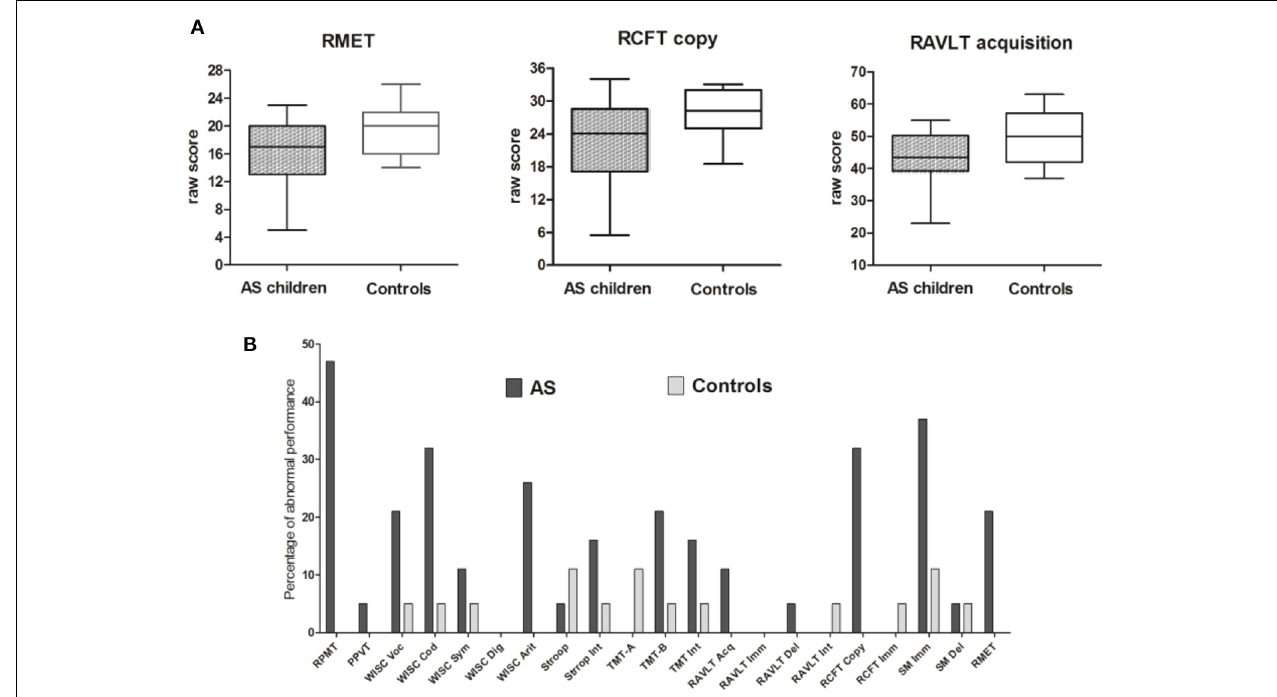
FIGURE 1 | Summary of main results for group and individual comparisons. (A) Box plots of each significant group differences between AS and control groups. (B) Percentage of individuals with extreme performance on each measure from the neuropsychological assessment. Gray (control group) and black (AS group) columns represent the percentage of individuals with extreme performance (either sub- or supra-normal performance) (see Figures 2A,B for a detailed description). ∗ RPMT, Raven’s Progressive Matrices Task; PPVT, Peabody Picture Vocabulary Test; WISC voc, Wechsler Intelligence Scale for Children vocabulary subtest; WISC cod, Wechsler Intelligence Scale for